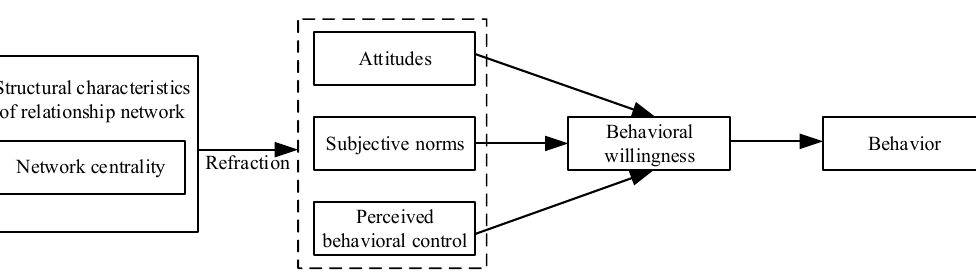
Figure 2. The TPB, incorporating network